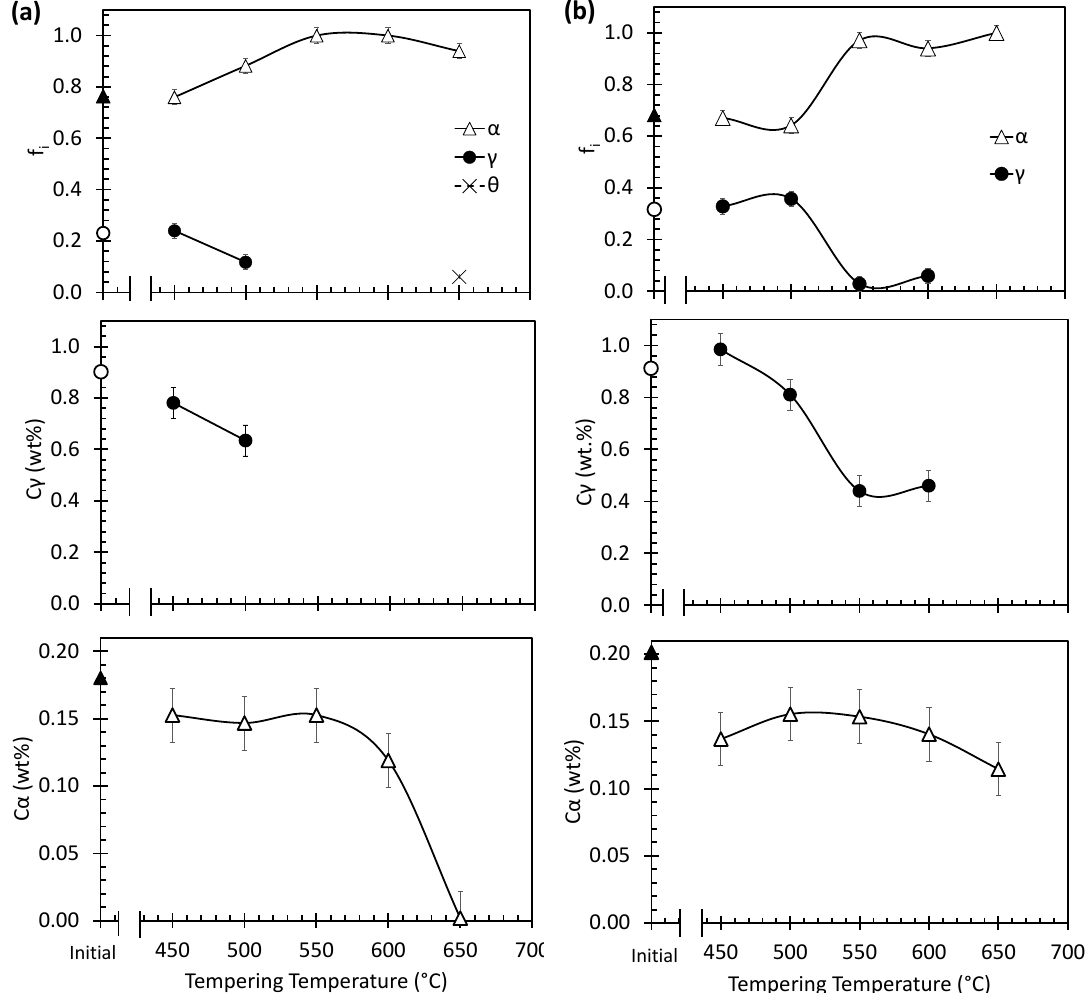
Figure 11. Summary of XRD results as a function of tempering temperature for ( a ) 06CV and ( b ) 06C1MoV steel.